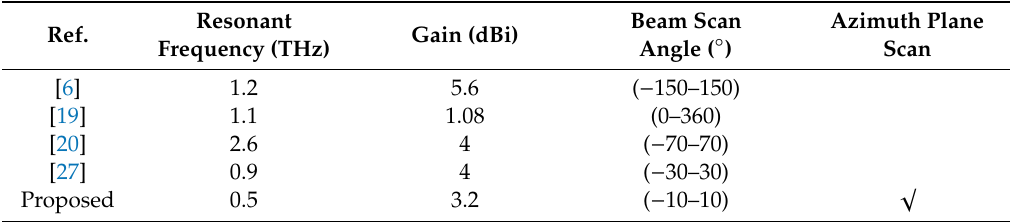
Table 1. Performance of the proposed graphene